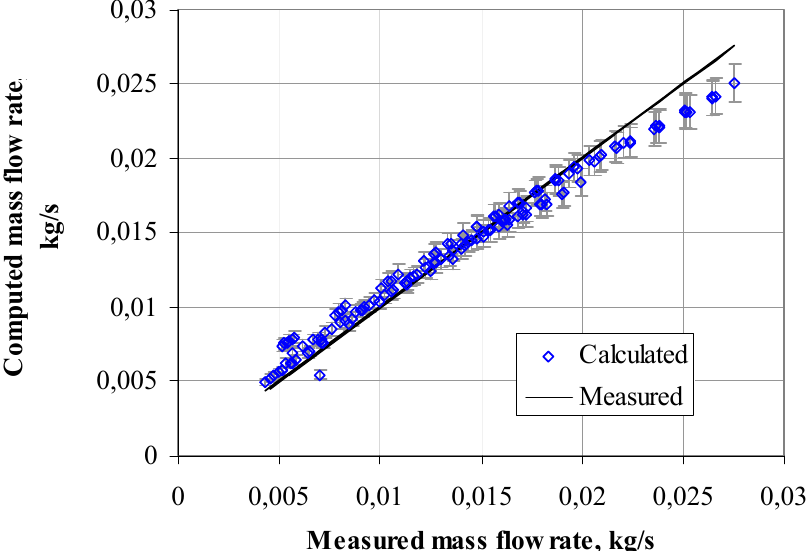
Figure 3. Comparison between calculated and measured mass flow rates of the